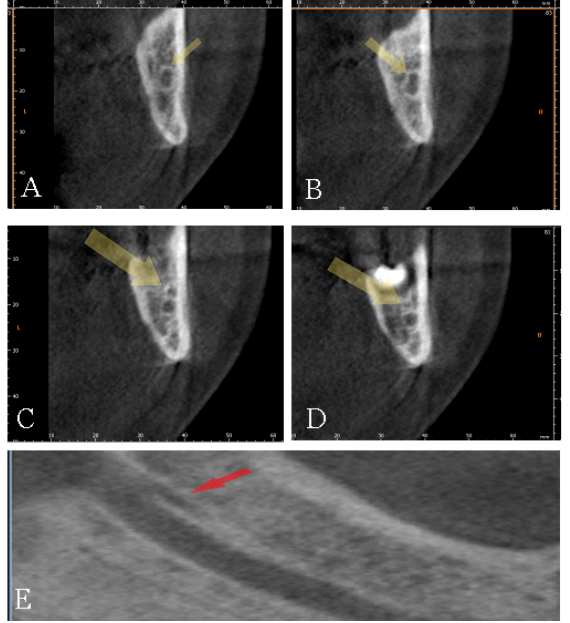
Figure 8. Type 3, not confluent canal: ( A – D ) cross-section reconstructions and ( E ) Panorex reconstructions. Arrows indicate the presence of the canal.